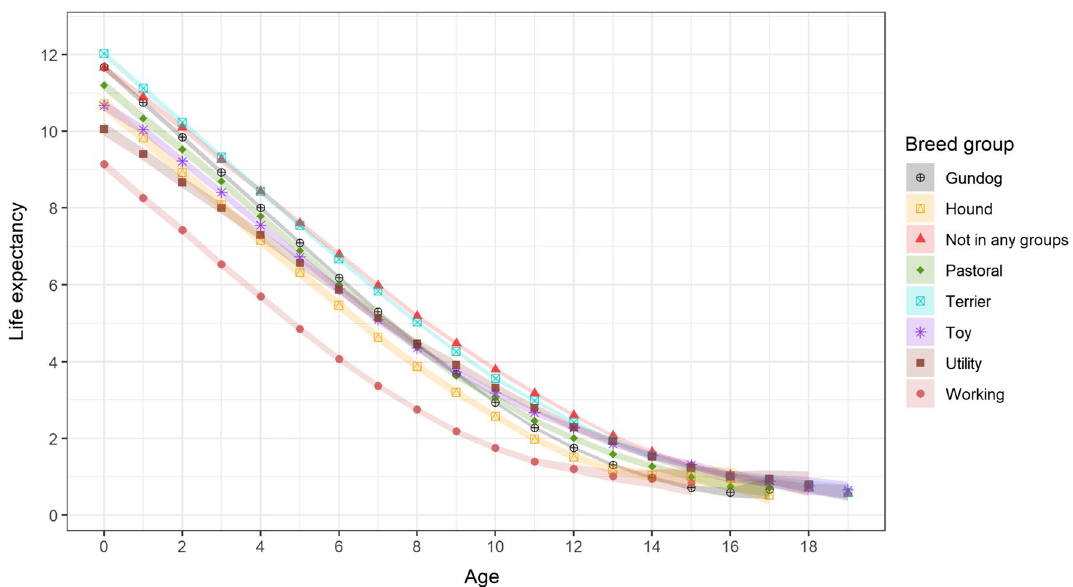
Figure 2. Life expectancy and the 95% confidence interval for dogs of different Kennel Club breed groups under primary veterinary care in the